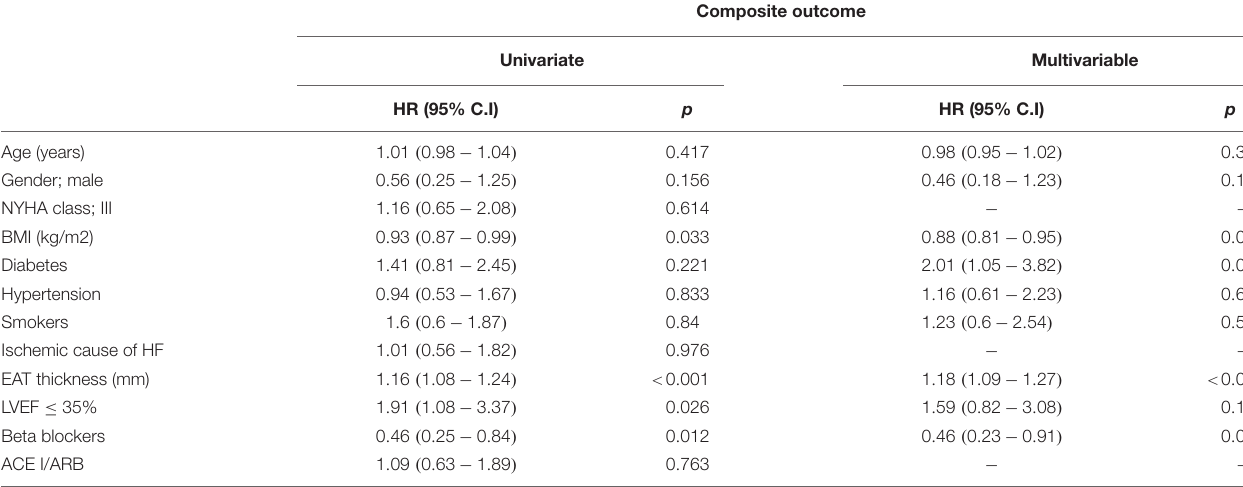
TABLE 2 | Predictors of the composite outcome.